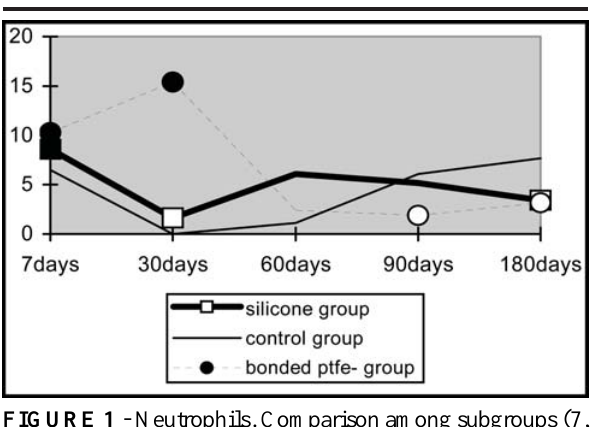
FIGURE 1 - Neutrophils. Comparison among subgroups (7, 30, 60, 90 and 180 days), of each group separately. The significant value is indicated with a dark line and the comparison in a light